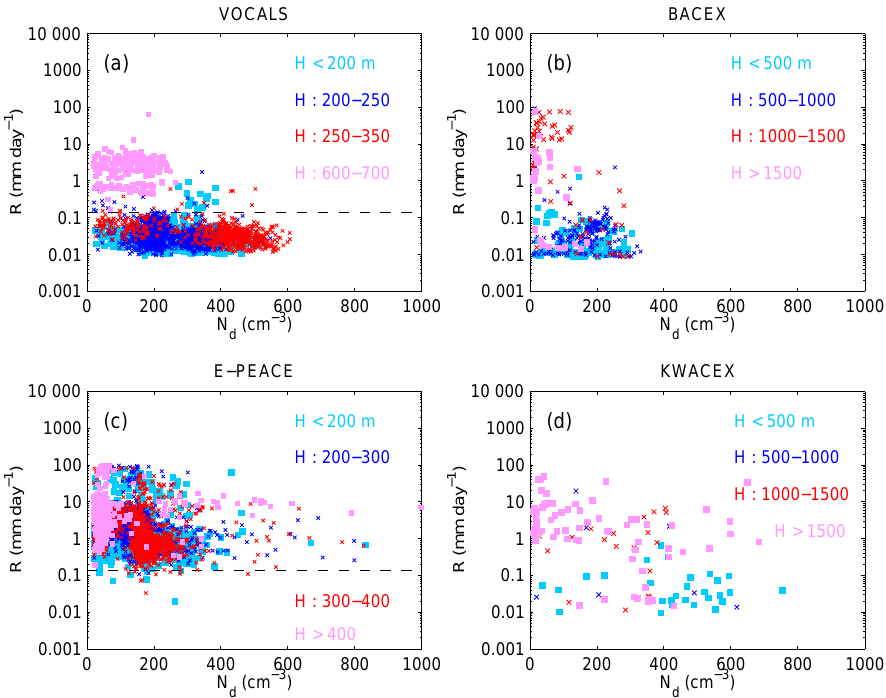
Figure 2. Scatter diagrams of cloud droplet number concentrations, N d , and precipitation, R , for four field campaigns. Colors indicate cloud thickness H . The dashed line indicates an R value of 0.14mmd − 1 .